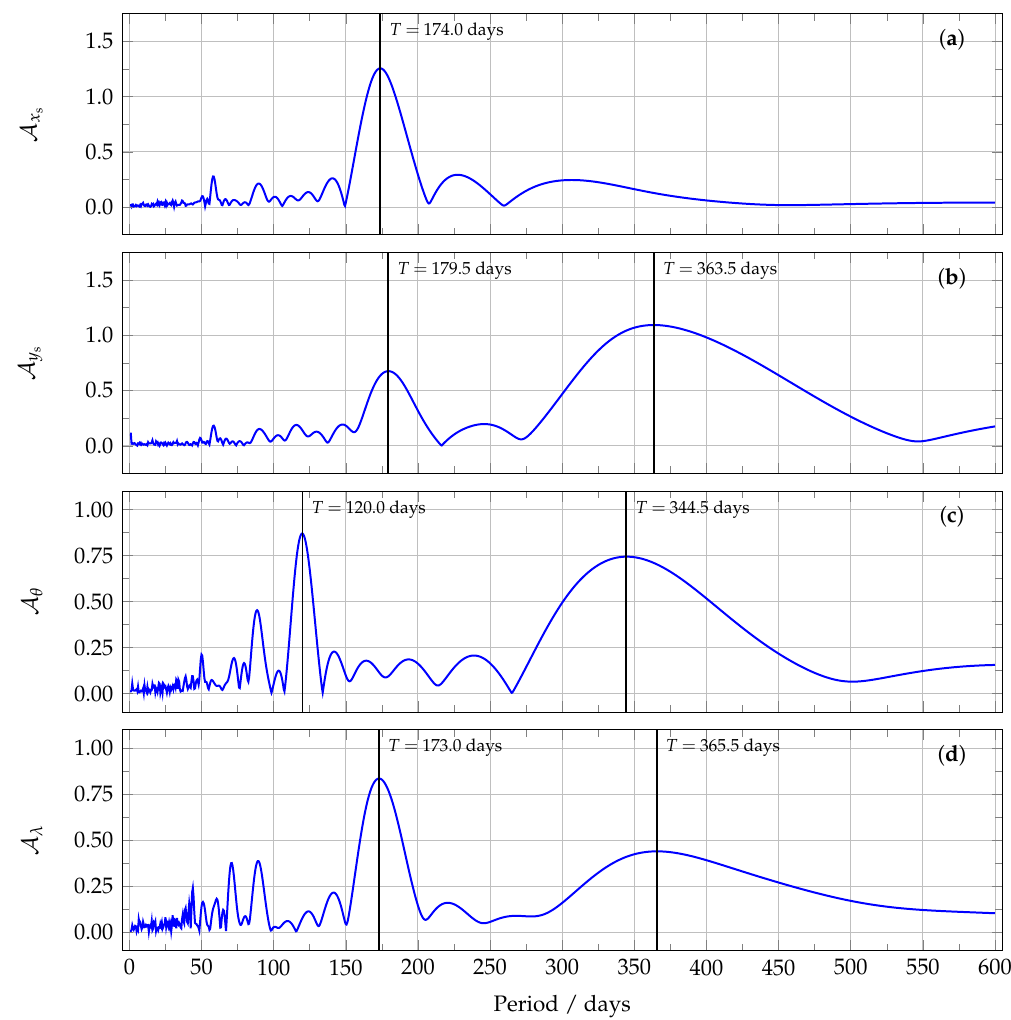
as a function of the time period in days for every Figure 9. Normalised periodogram amplitude A transformation parameter: ( a ) the horizontal shift x s ; ( b ) the vertical shift y s ; ( c ) the rotation angle θ ; and ( d ) the radial distortion parameter λ